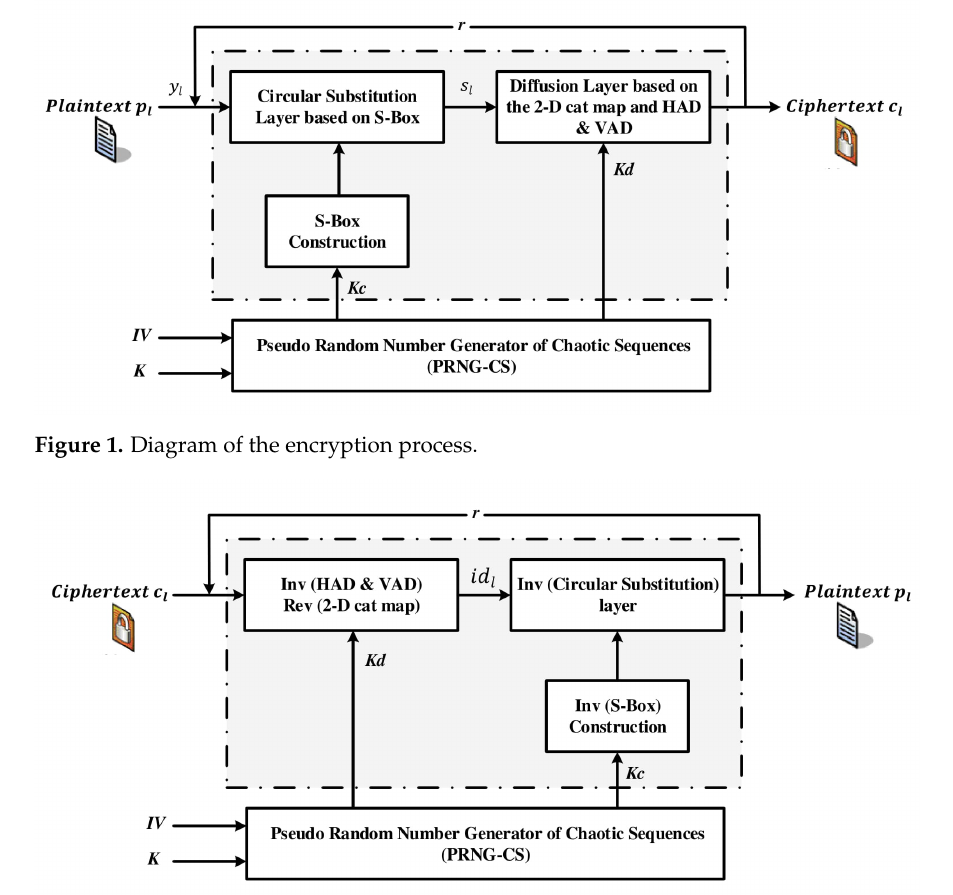
Figure 2. Diagram of the decryption